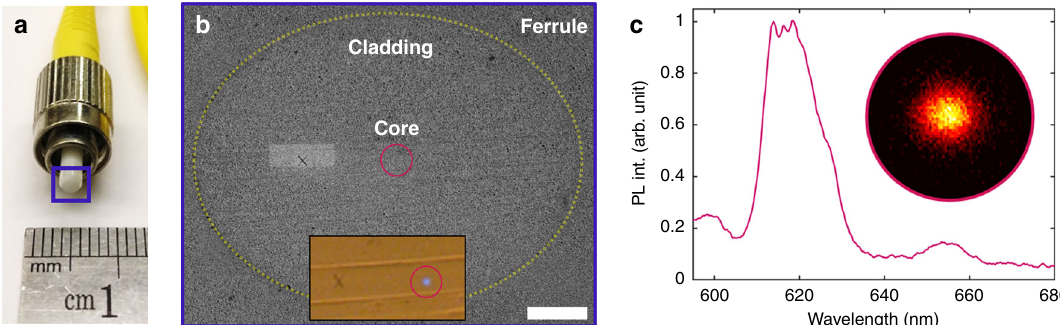
Fig. 4 Implantation of rare earth ions into a commercial optical fi bre. a Picture of the fi bre used in this experiment. The end face is highlighted. b SEM image of the fi bre end face during the implantation process. The yellow outline marks the boundary of the cladding to the ferrule, which was used to identify the core. The inset shows the core (back illuminated) relative to a correlation marker. The scale bar corresponds to 20 μ m. c Emission of the implanted Eu 3 + , excited through the other fi bre end (PL map shown as